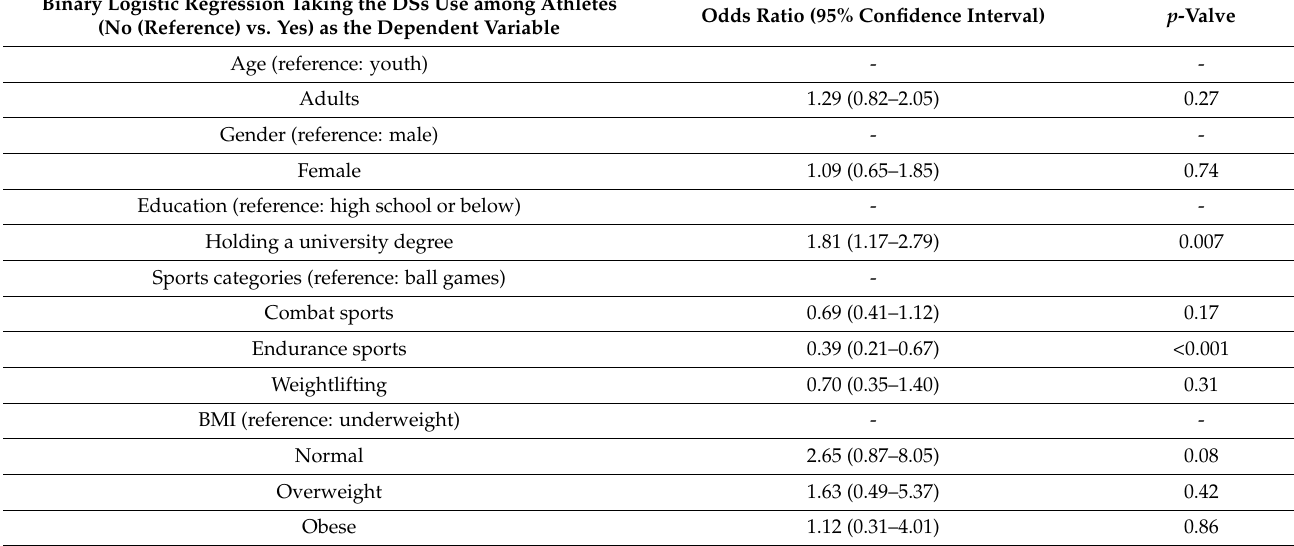
Table 4. Determinants of DSs use among